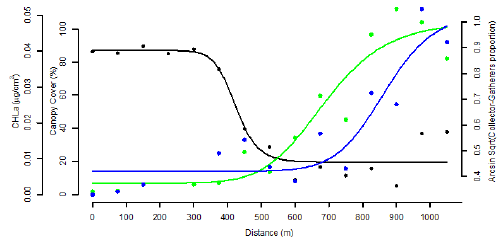
Figure 2. Selected nonlinear models for canopy cover percentage (black), benthic chlorophyll a concentration (green), and collector-gatherer invertebrate proportion throughout the 15 sampling sites along the forest-pasture transition in the Itaperiti stream (Rio de Janeiro, Brazil). Note different scales for the different